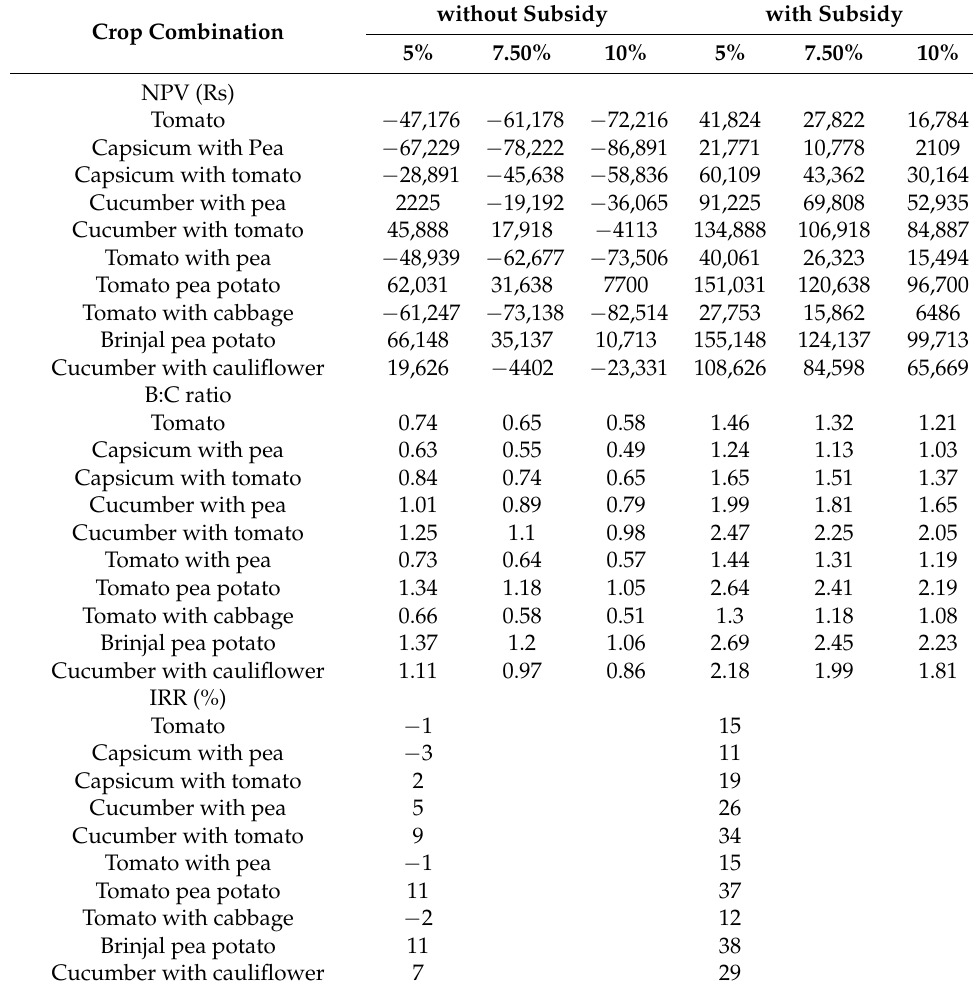
Table 17. Feasibility analysis of protected cultivation of vegetables under GI-frame polyhouse in Almora district of Uttarakhand under climate change